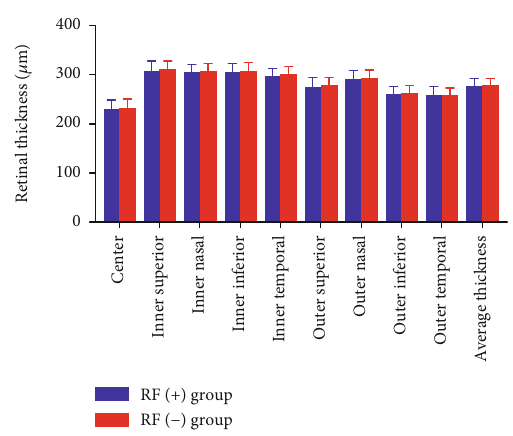
Figure 1: The retinal thickness by group. There was no statistically signi fi cant di ff erence regarding the retinal thickness between the RF (+) group and the RF ( − ) group.